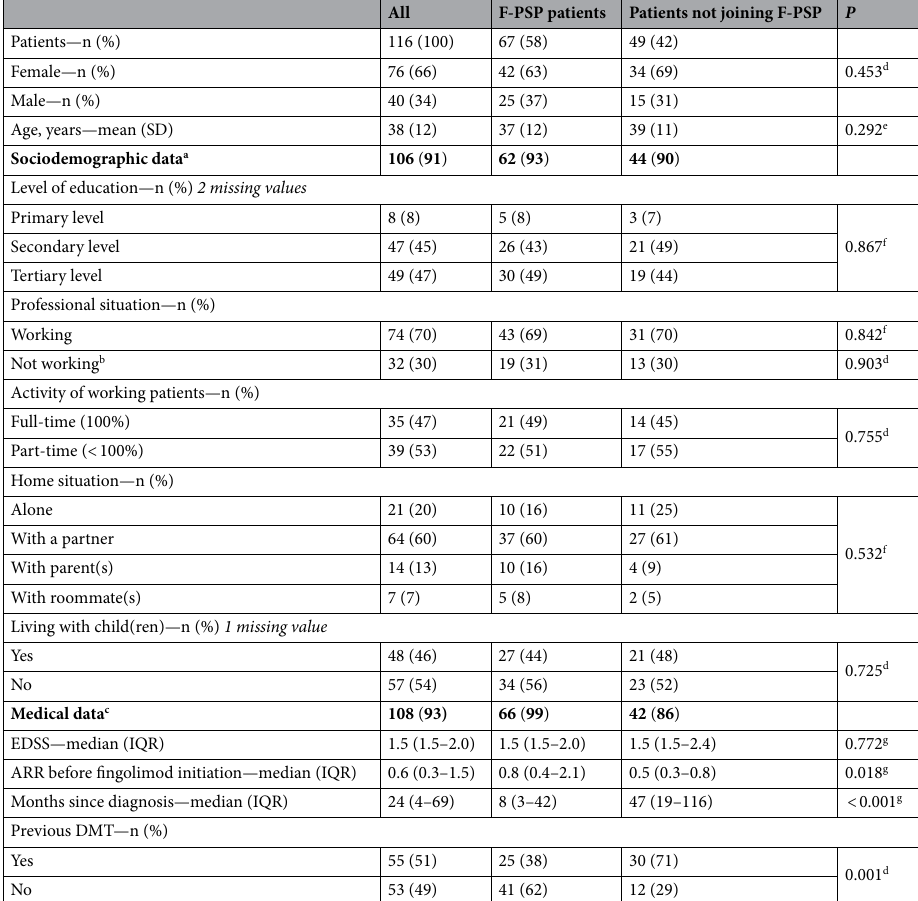
Table 1. Sociodemographics and medical characteristics of F-PSP patients and of patients who did not join the F-PSP at the time of fingolimod initiation. AAR: annualized relapse rate; DMT: drug modified therapy; EDSS: Expanded Disability Status Scale; IQR: interquartile range; n: number; SD: standard deviation. a